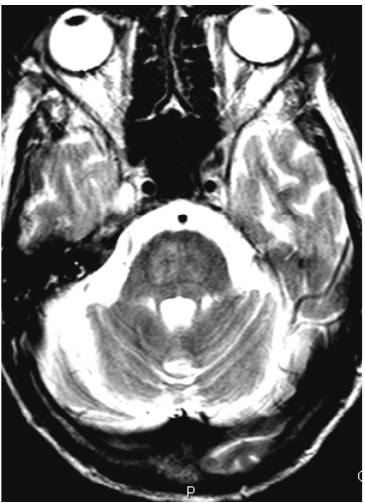
Figure 2: T2 magnetic resonance imaging demonstrating central pontine myelinolysis.